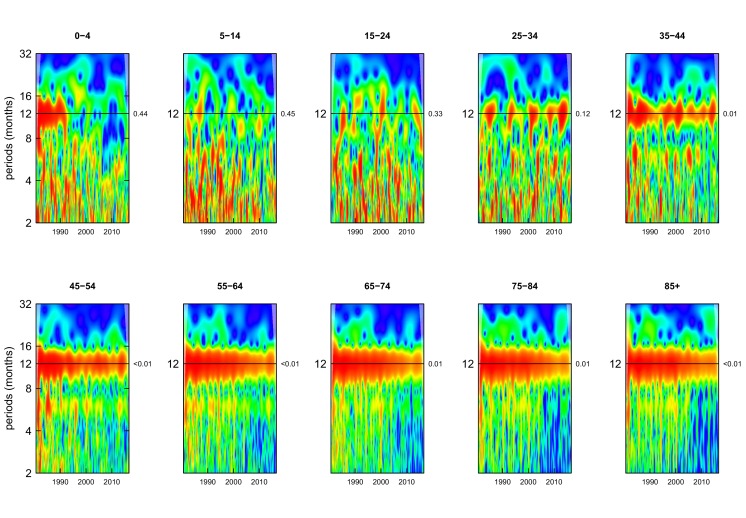
Wavelet power spectra for national time series of cardiovascular disease death rates for 1980–2016, by age group for males.Wavelet power values increase from blue to red. The shaded regions at the left and right edge of each box indicate the cone of influence, where spectral analysis is less robust. P-values for the presence of 12 month seasonality are to the right of each figure at the 12 month line.